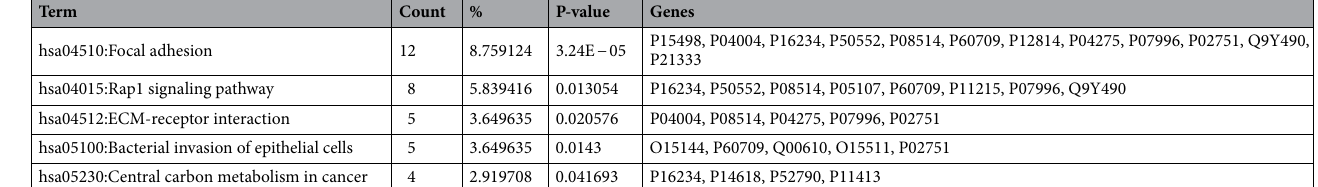
Table 1. KEGG pathway of downregulated proteins in tumor margin tissue treated with irradiated WF by DAVID enrichment database.